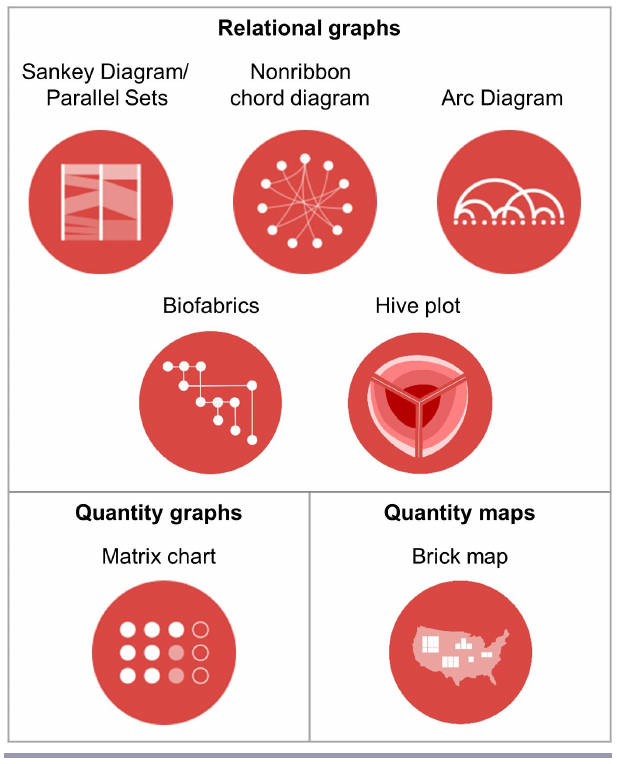
Fig. 10 . Selection of additional visualization techniques suitable for the visualization of telecoupling connections, grouped by the visualization